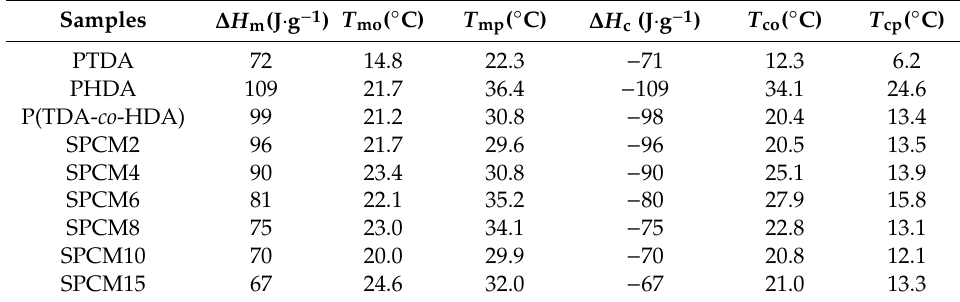
DSC heating curve; T co —onset crystallizing temperature on the crystallization curve; T cp —peak crystallizing temperature on the crystallization curve.